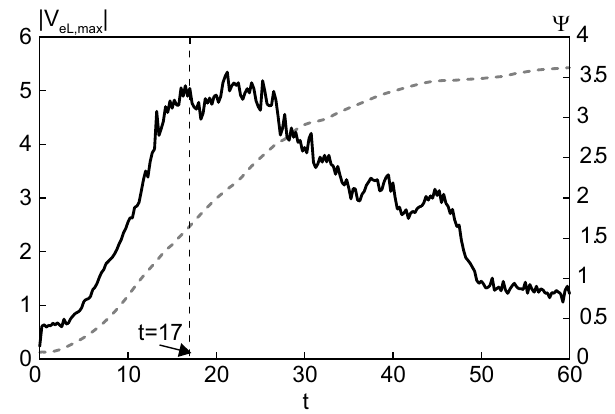
Fig. 3. Temporal developments of the reconnected magnetic flux 9 , (dashed gray line with right vertical axis), and the maximum | V eL | (solid black line with left vertical axis) of the present